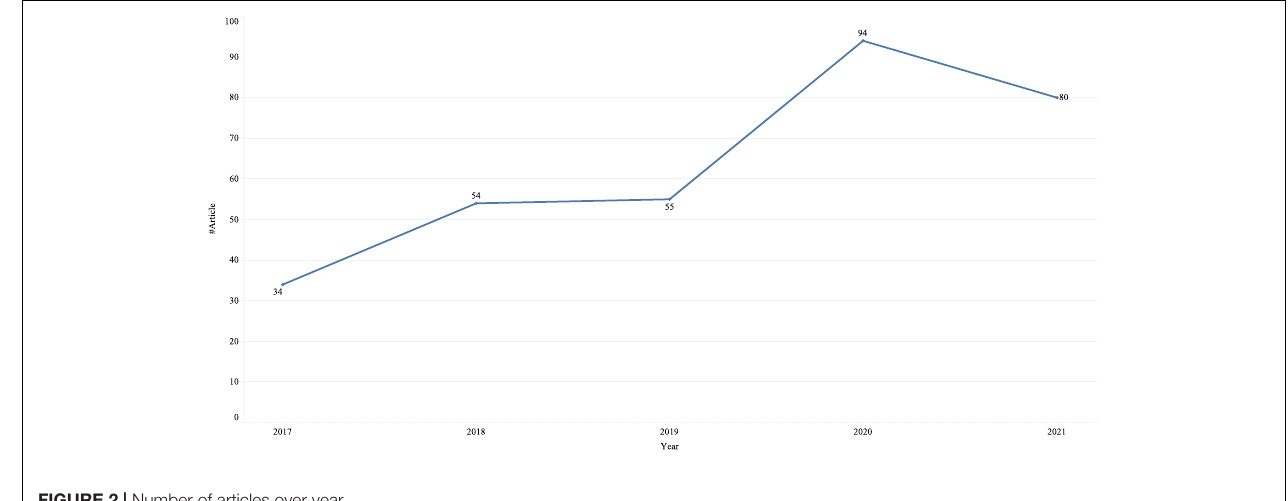
FIGURE 2 | Number of articles over